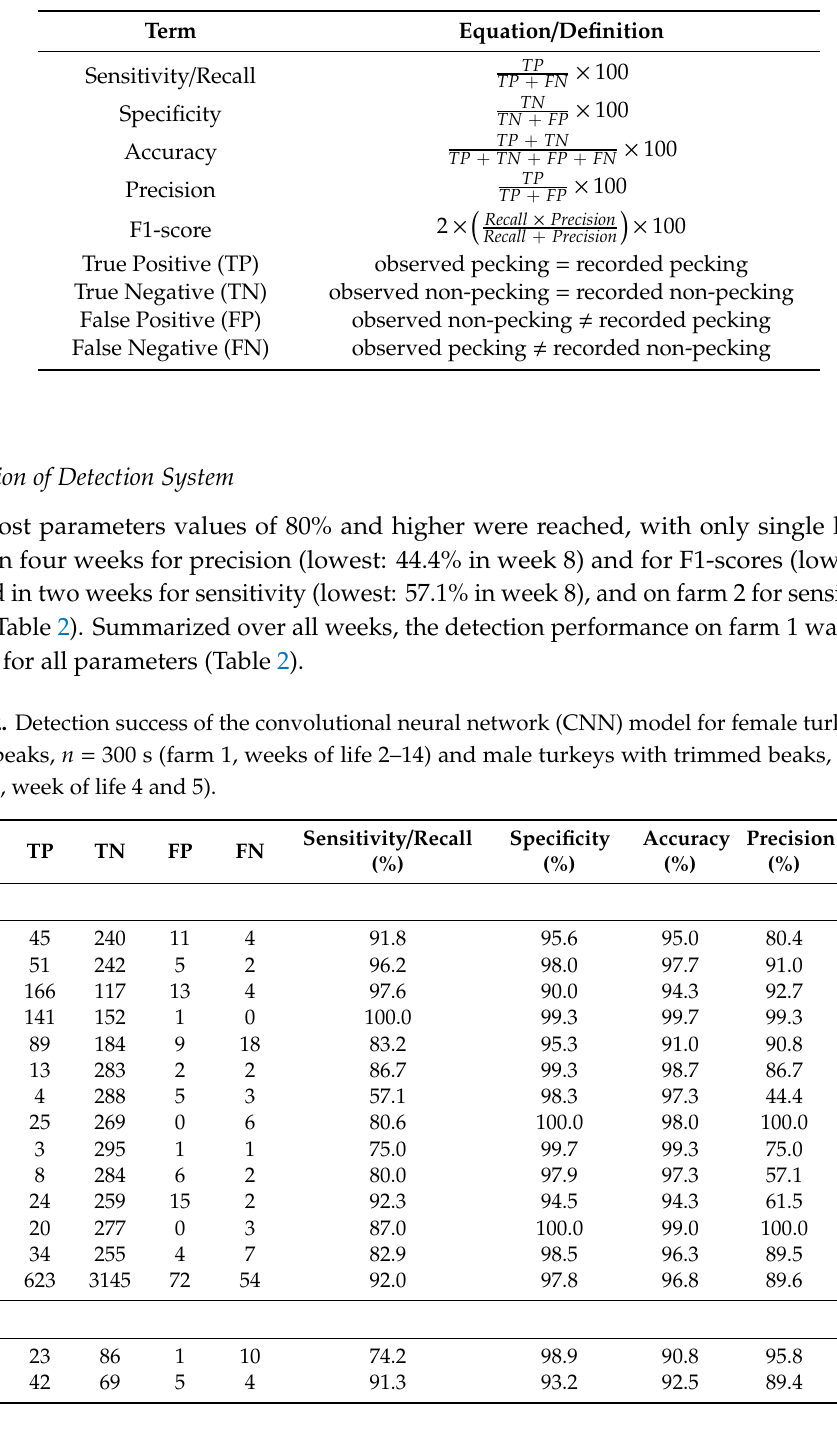
Table 1. Equation and definition of evaluation parameters.